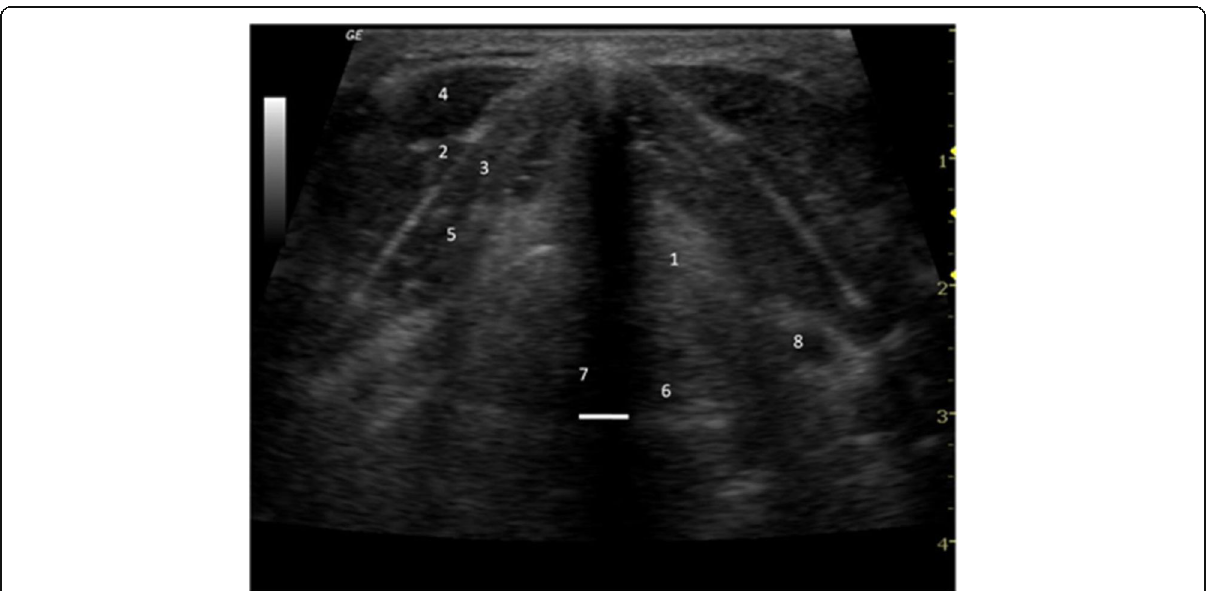
Fig. 1 An ultrasound photo of one of our patients showing different laryngeal structures: 1 — ventricular folds, 2 — outer thyroid plate, 3 — inner thyroid plate, 4 — strap muscles, 5 — paraglottic space, 6 — arytenoid cartilage, 7 — inter-arytenoid distance, 8 — pyriform sinus